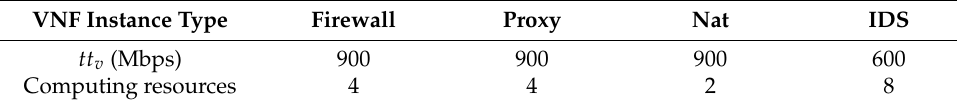
Table 2. Throughput and computing resource requirements of different